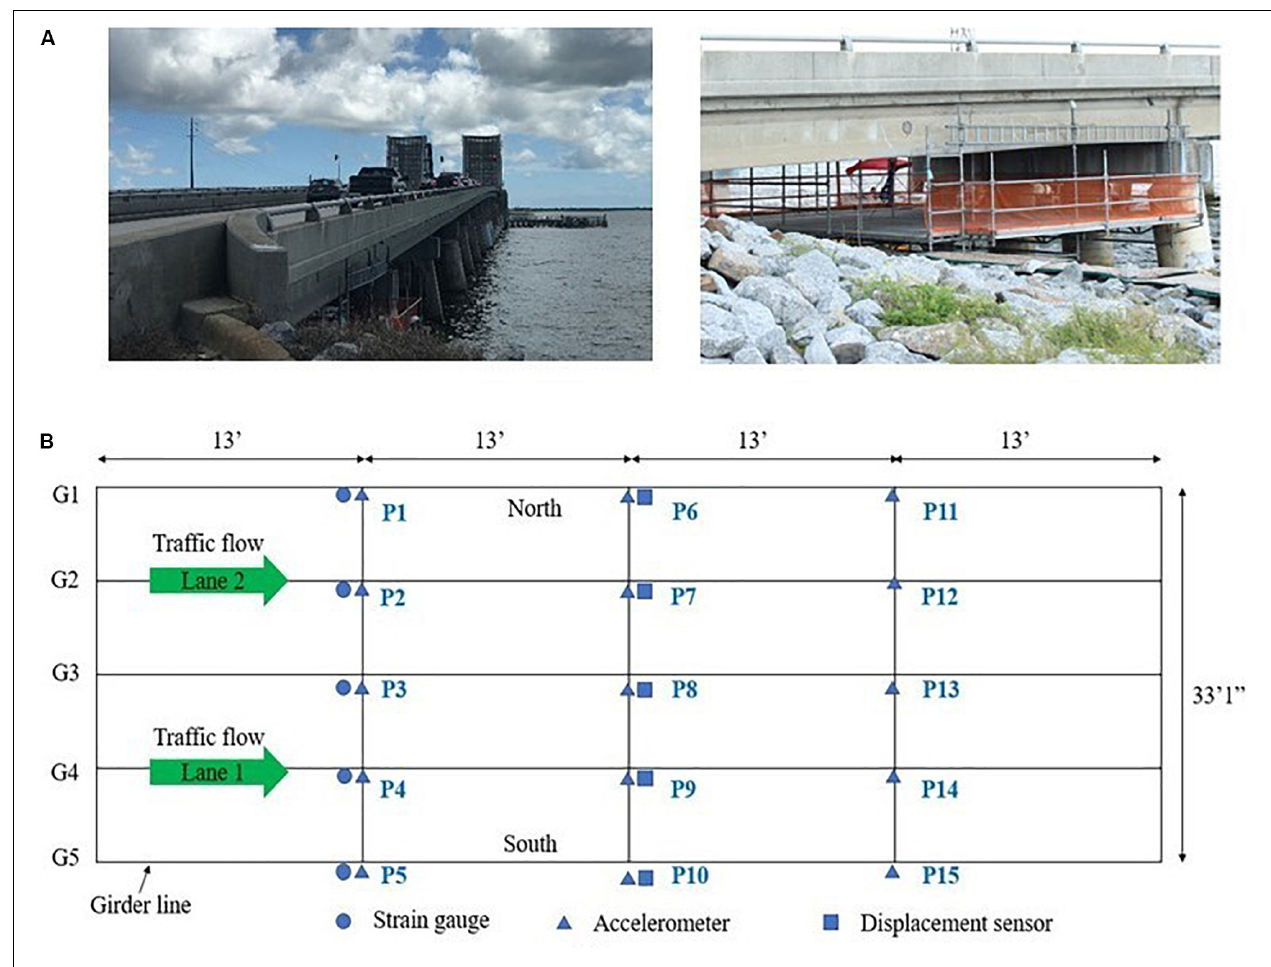
FIGURE 1 | (A) The concrete highway bridge (B) Sensor instrumentation